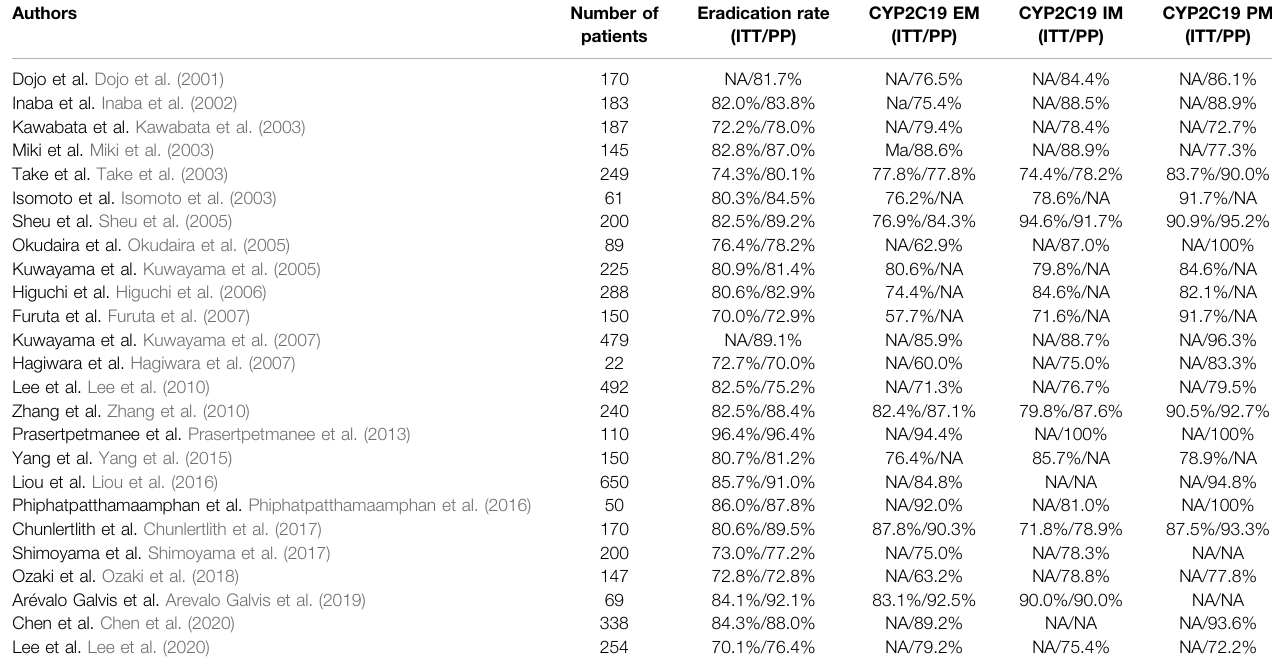
TABLE 2 | Eradication rates of PPI-amoxicillin-clarithromycin triple therapy among CYP2C19 genotypes.